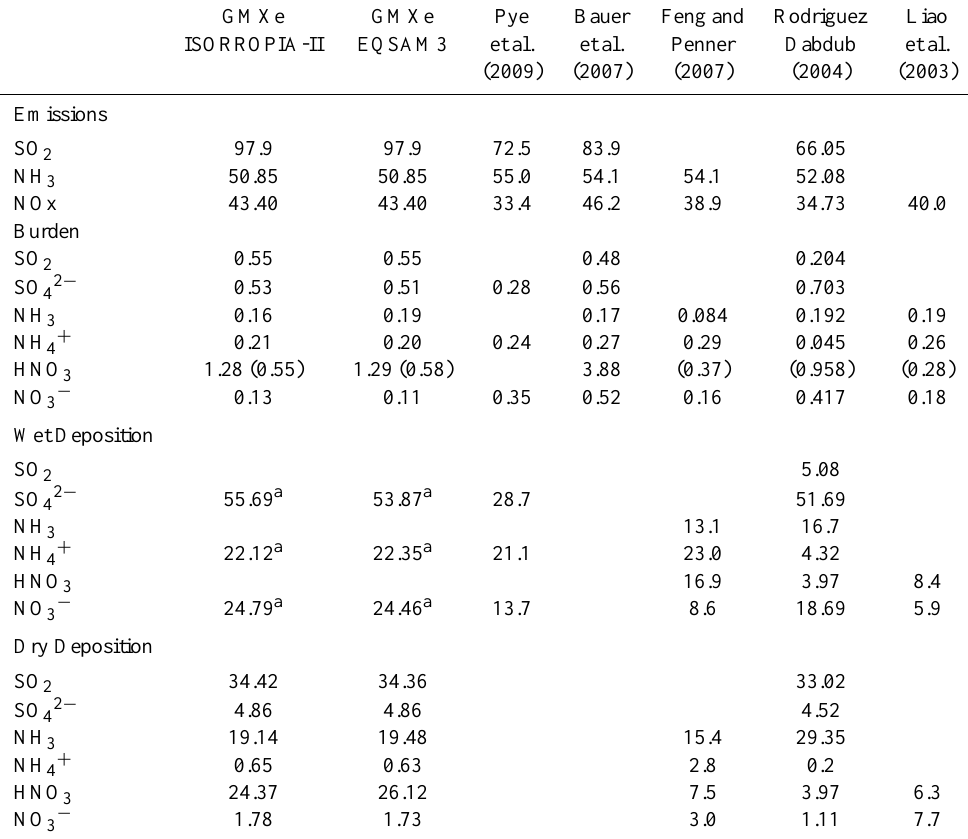
Table 5. Comparison of burdens with other studies. As HNO 3 concentrations above the troposphere contribute significantly to the global burden, tropospheric only burdens are given in brackets. For GMXe the tropospheric value is defined as the burden in all model layers with at pressure > 150hPa. a EMAC only reports the sum of the gas+aerosol phase wet deposition, thus value for e.g. NH 4 + is the wet deposition of ammonia + ammonium (same for HNO 3 and H 2 SO 4 ). All units are TgN(or S)yr − 1 . GMXe